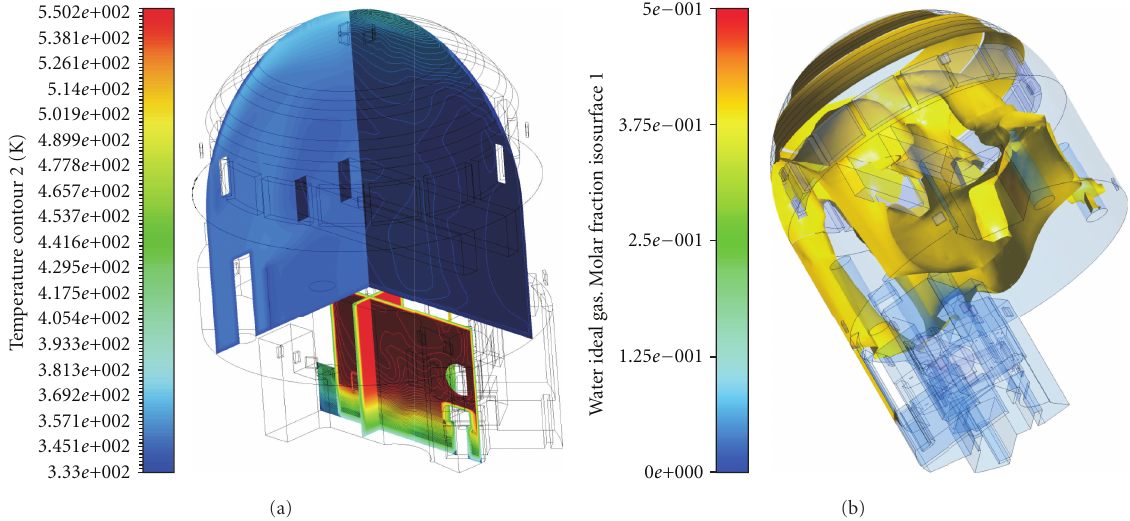
Figure 8: Calculated results of the temperature field (K) (a) and isosurface of 40-percent molar fraction of steam (b) in containment rooms.